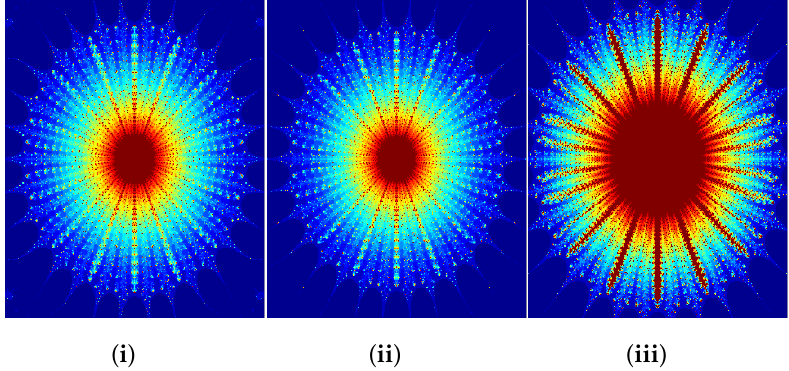
Figure 11. Higher-order Julia sets in ( i ) Noor-orbit; ( ii ) Ishikawa-orbit; ( iii ) Mann-orbit.